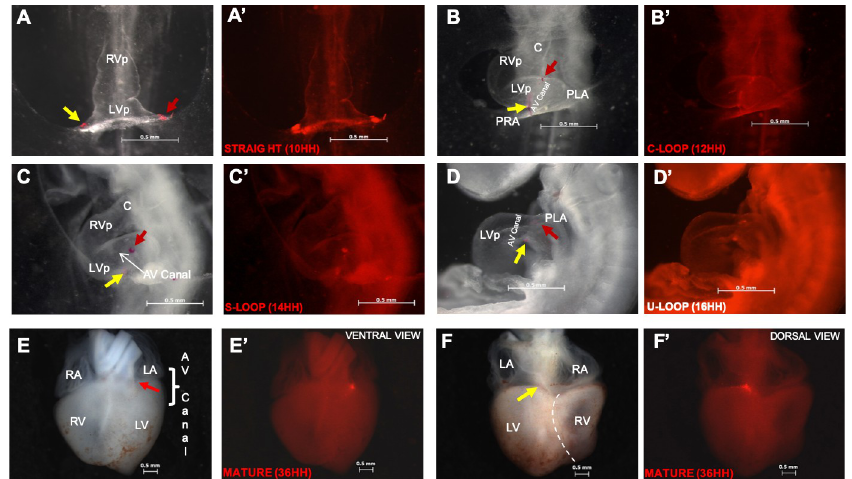
Fig 2. Posterior segment of the straight heart tube is involved in the development of the atrioventricular canal and left ventricle. (A, A’) Straight heart tube with a label on the distal end of the posterior segments of the right (yellow arrow) and left (red arrow) branches. (B, B’) C-looped heart. Note the tubular shape of the proximal region of the posterior segment of the straight heart tube. The right and left caudal regions, which are supposed to be the primitive atria, remain bifurcated. (C, C’ and D, D’) S- and U-looped hearts. Note that the originally bifurcated posterior segment of the straight heart tube acquired a tubular shape. Labels at the right and left borders of the posterior segment of the straight heart tube converged at the currently named atrioventricular grooves, adjacent to the atrioventricular canal. (E, E’ and F, F’) Ventral and dorsal views of a mature heart. Observe labels at the level of the ventral (red arrow) and dorsal (yellow arrow) atrioventricular canal wall. Abbreviations: AV, atrioventricular; C, conus; LA, left atrium; LV, left ventricle; LVp, left ventricle primordium; PRA, primitive right atrium; PLA, primitive left atrium; RA, right atrium; RV, right ventricle. Dotted line represents the interventricular septum. https://doi.org/10.1371/journal.pone.0234069.g002 primordium) occupied the right position (Fig 1C and 1C’) between what are now known as the conoventricular grooves (74% labels from the cephalic limit), and which were named by de Table 2. Displacement of labels from the cephalic and caudal limits of the anterior segment of the straight heart tube to the interventricular septum. TRACKING OF THE ANTERIOR SEGMENT OF THE STRAIGT HEART